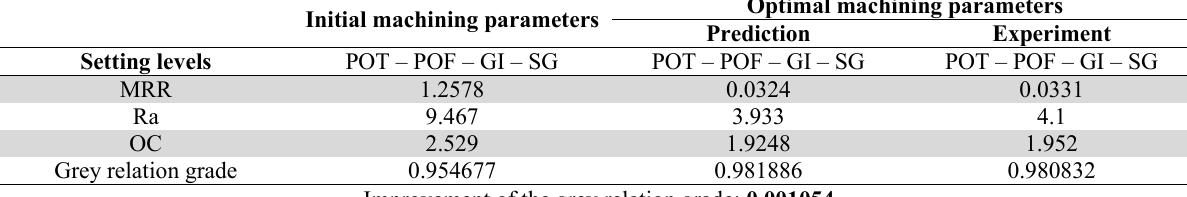
Results of machining performance using the initial and optimal machining